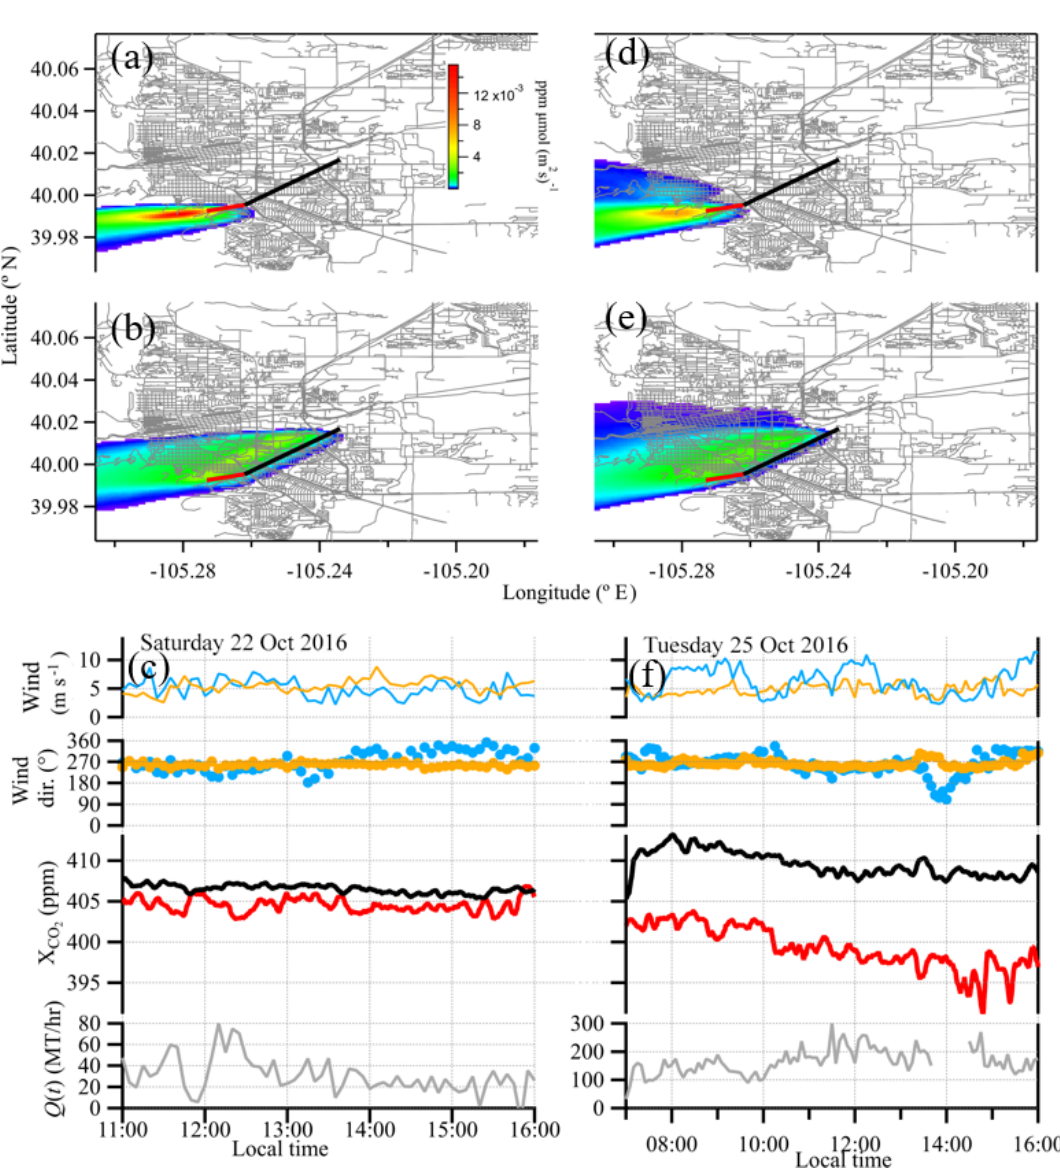
Figure 7. Footprint calculations and time series data for the 2 case study days. Left column – Saturday, 22 October 2016 data; right column – Tuesday, 25 October 2016 data. Upper panels (a, d) : footprints for the reference path. Middle panels (b, e) : footprints for the over-city path. The footprints are averaged over the respective time windows and open paths. Lower panels (c, f) : wind and CO 2 data at 5min time intervals. Reference and over-city measurement paths are shown in red and black, respectively. Data plots show X CO (red) and city path (black), wind speed and wind direction measurements taken at NCAR-Mesa (blue) and NCAR-Foothills (orange), and the calculated Q(t) . On 25 October, Q(t) data near 14:00 have been removed since the reference path wind direction is out of the southeast to the east, resulting in city contamination along the reference path. All data are smoothed to 5min time